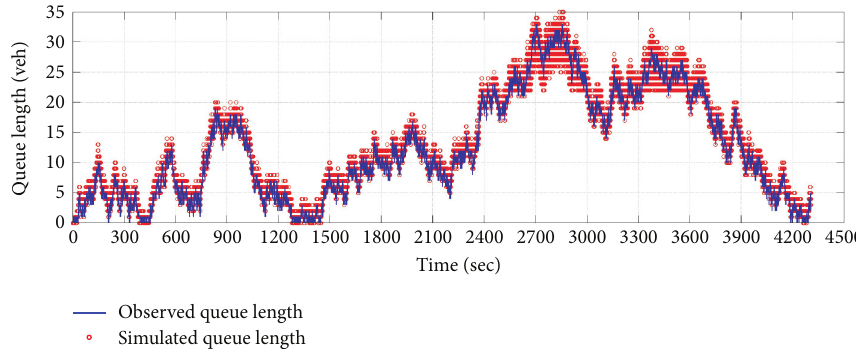
Figure 7: Comparison of queue lengths at every second in the evolution between 1000 simulations and observation in one case.